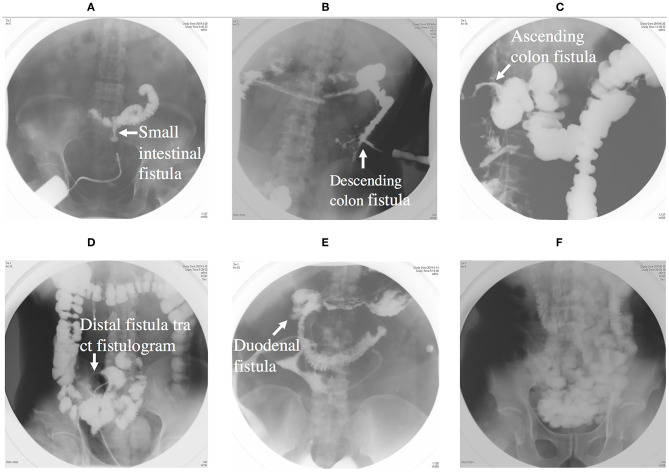
(A) Showing an intestinal fistula through fistula tract imaging. (B) Showing a descending colon fistula. (C) Showing an ascending colon fistula. (D) Showing distal intestinal tract of fistula. (E) Showing a duodenal fistula. (F) Showing proximal intestinal tract.